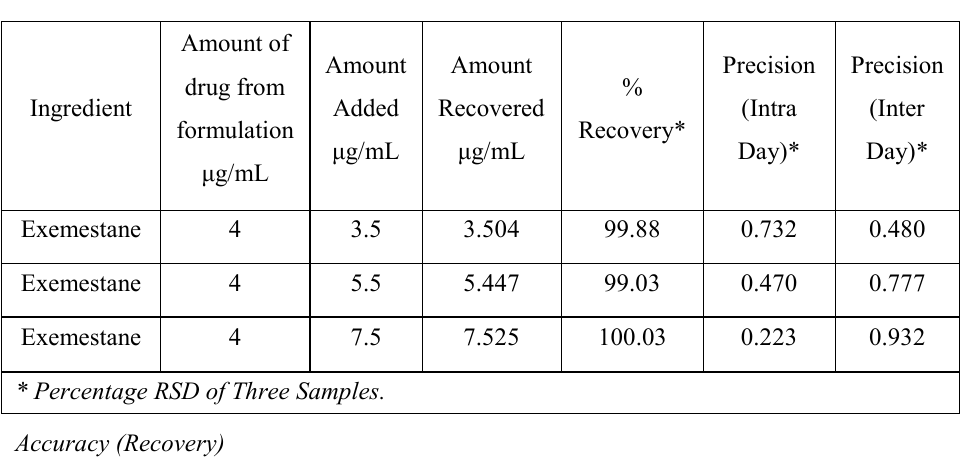
Table 3. Results of Recovery and